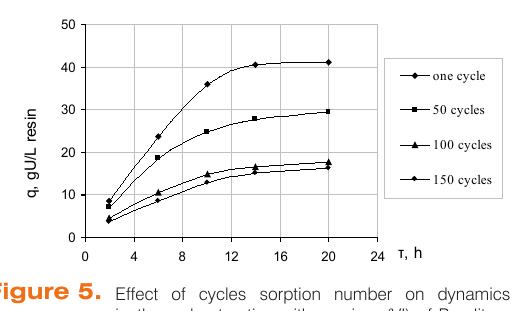
Figure 5. Effect of cycles sorption number on dynamics of isothermal saturation with uranium (VI) of Purolite resin SG 600 U / 3472. i) anions solution composition:U (VI) -0.66 g L -1 , CO 32- -8.97 g L -1 , HCO 3- -8.85 g L -1 , SO 42- -10 g L -1 ; ii) t=20 0